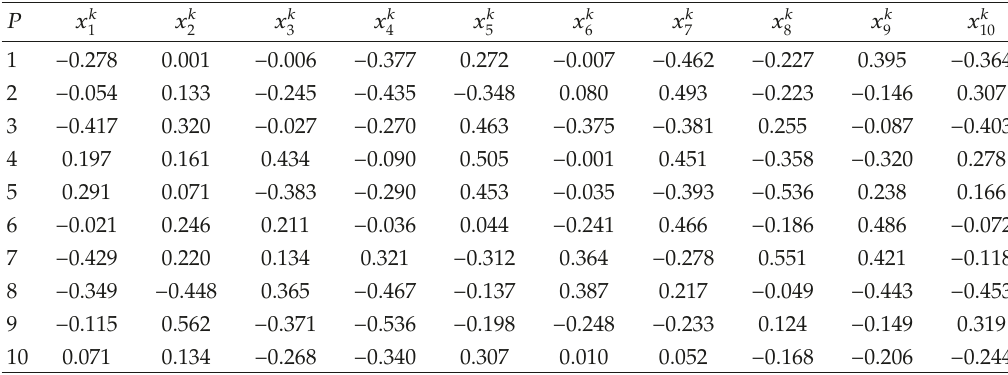
Table 1: Numerical results: Algorithm 3.4 with n (cid:7)